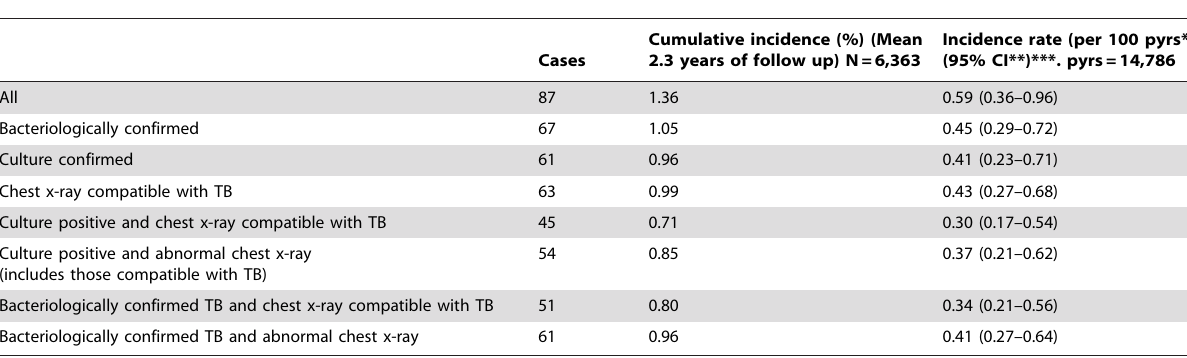
Table 3. TB incidence rates using different case definitions.